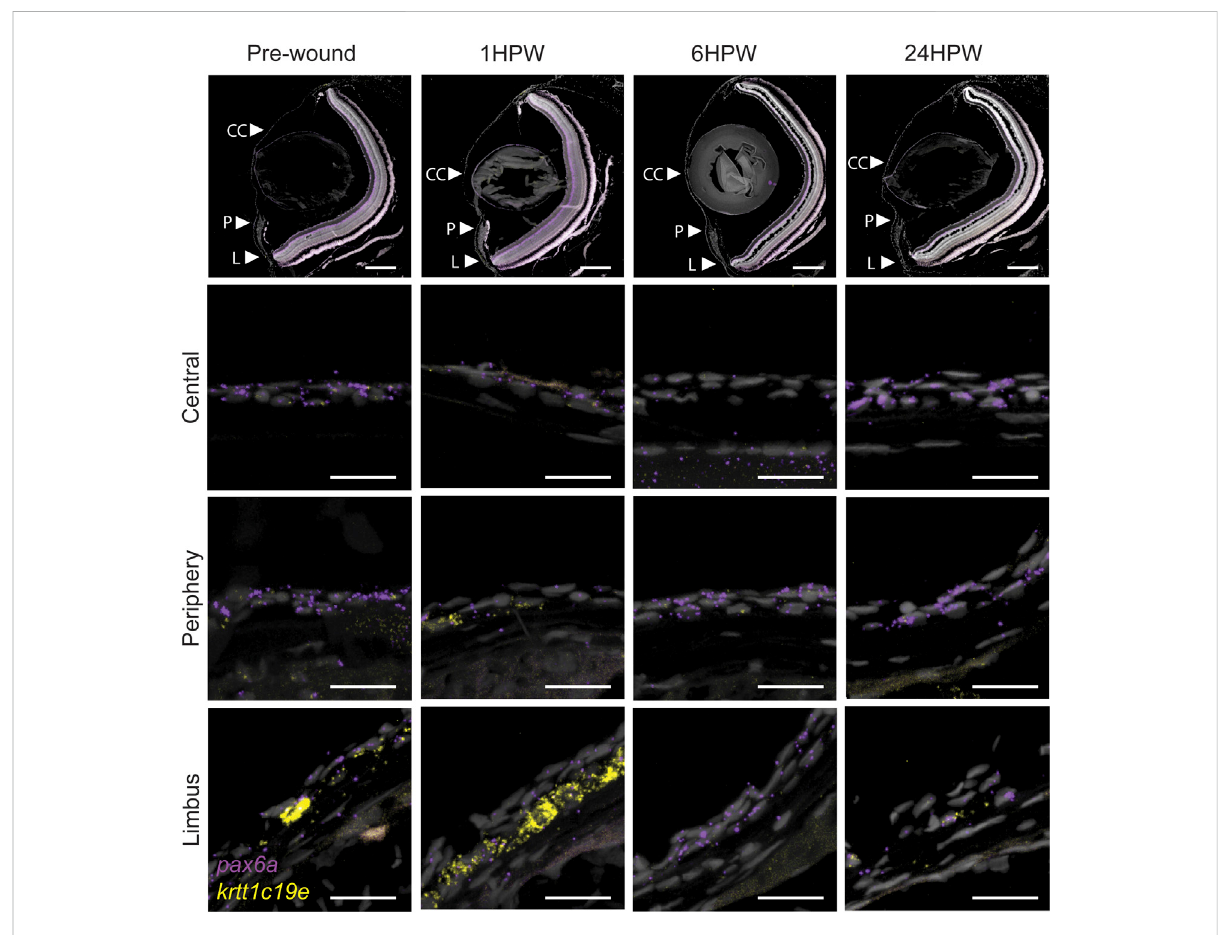
Gene expression changes in adult wound healing. RNAScope in situ hybridization on 5- µm sections showing theexpression of pax6a (red) and krtt1c19e (yellow)before, and after 1,6, or24 h,anepithelialabrasionon centralcornea. 3sampleswerechecked peragegroup. Scale bars:200 µm in the overview images, 20 µm in the magni fi ed